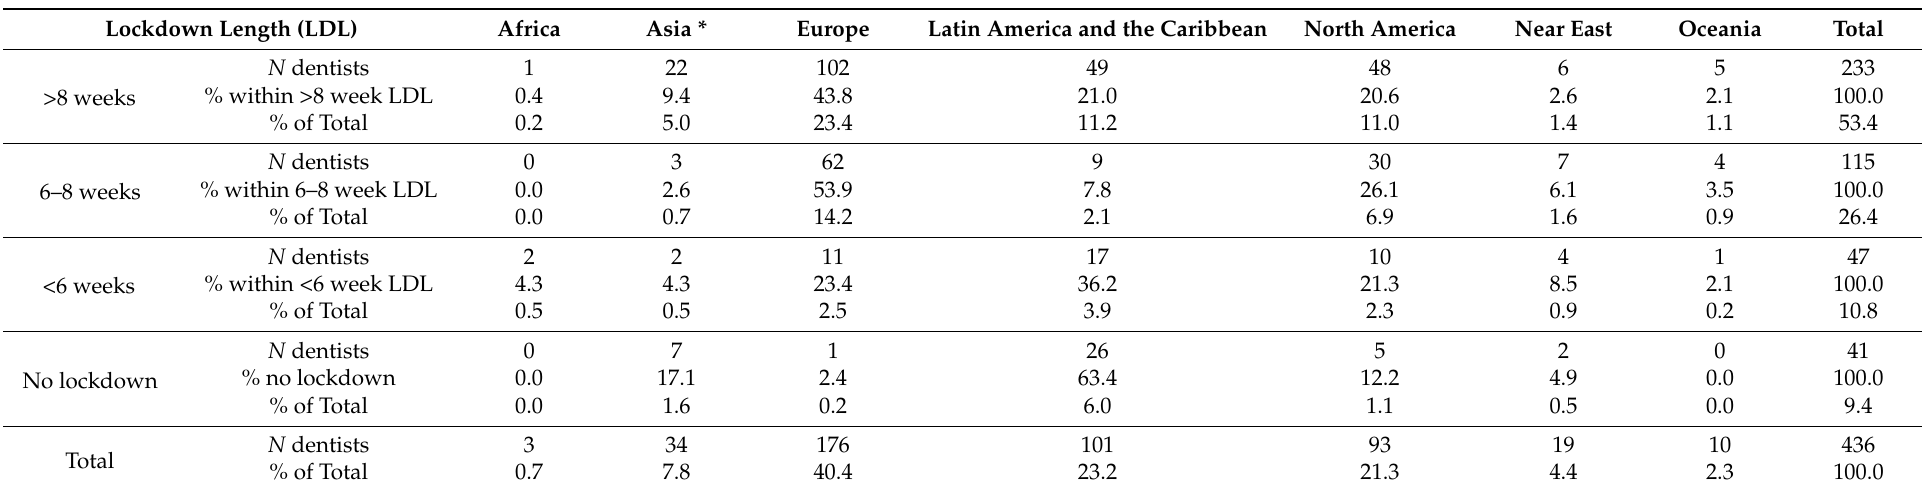
Table 2. Length of lockdown in terms of geographical